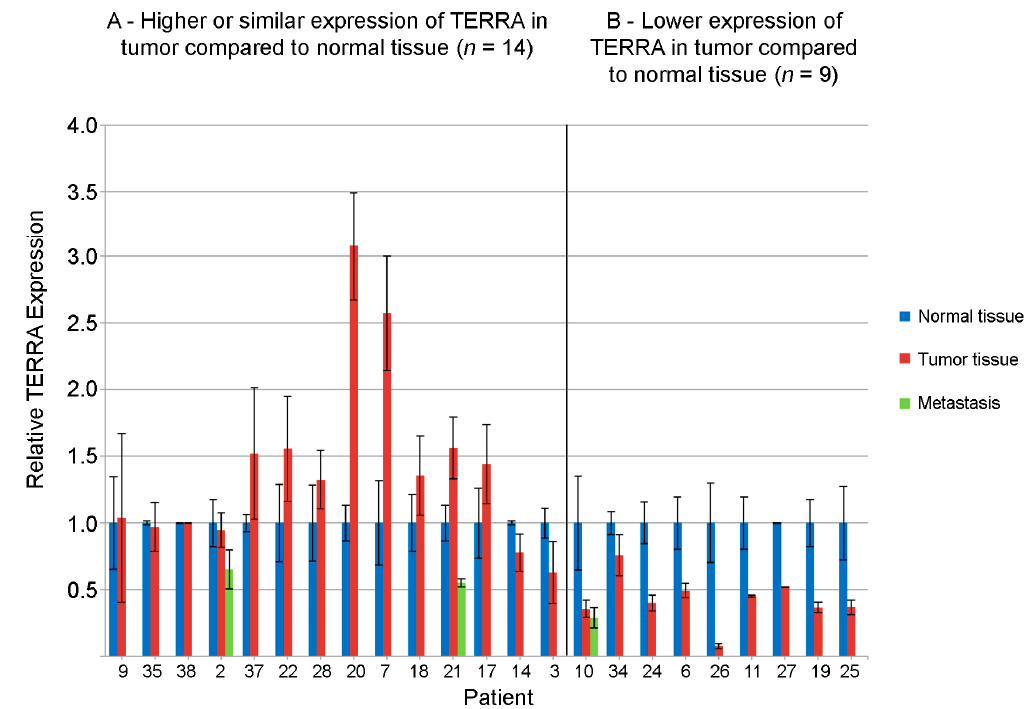
Figure 1. Quantification of total Telomeric Repeat-Containing RNA (TERRA) levels by slot blot hybridization in 23 head and neck squamous cell carcinoma (HNSCC) patients. Tumor samples (red bars), samples from metastatic tissue (green bars) and samples from adjacent nontumoral tissue (blue bars). For each patient, the value of the normal tissue has been set to 1. In group ( A ), the value in the tumor sample was either similar to the value in the healthy tissue ( p > 0.05) (patients 9, 35, 38, 2, 37, 28, 14, 3) or was significantly higher ( p < 0.05) (patients 22, 20, 7, 18, 21, 17). In group ( B ), the value in the tumor was significantly lower ( p < 0.05) than in the healthy tissue.